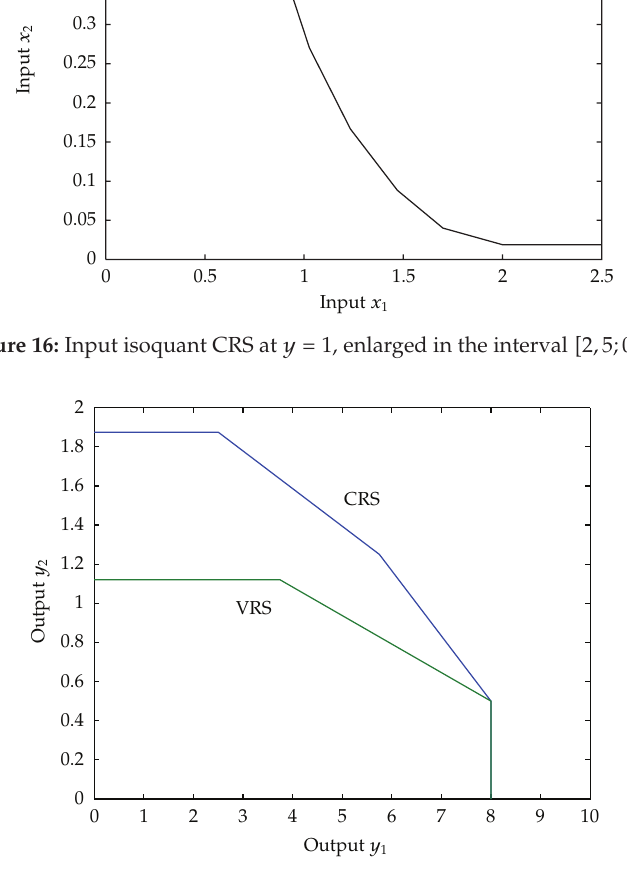
Figure 17: Output isoquants at x (cid:9)